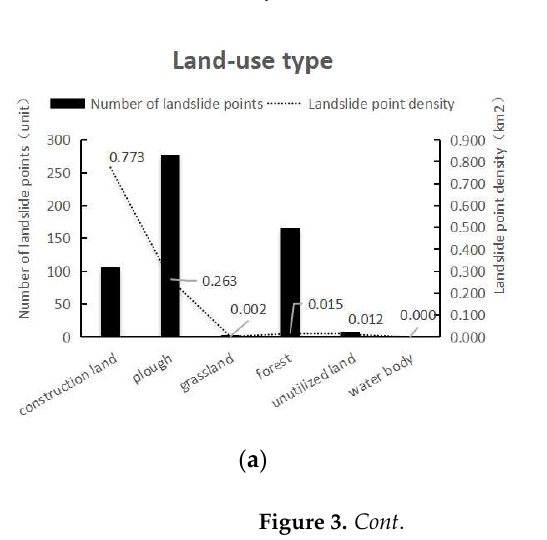
Figure 2. Single-factor grading diagram: ( a ) land-use type; ( b ) elevation; ( c ) slope; ( d ) aspect; ( e ) proximity to rivers; ( f ) lithology; ( g ) proximity to faults; ( h ) proximity to road; ( i ) precipitation; ( j ) NDVI.